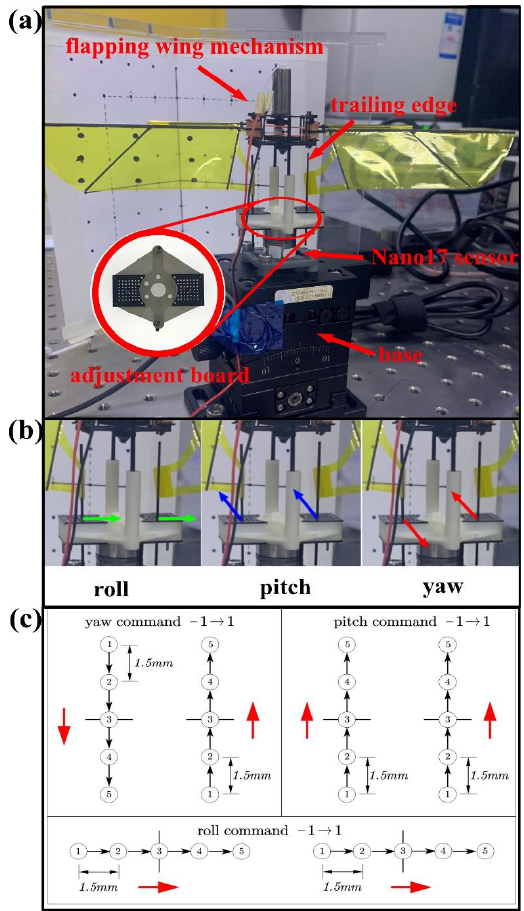
Figure 16. F/T measurement system for control torque produced by trailing edge movement. ( a ) The connection of flapping wing mechanism and sensor. ( b ) The correspondence between the trailing edge movement and control command. ( c ) The position of the trailing edge under different control commands.